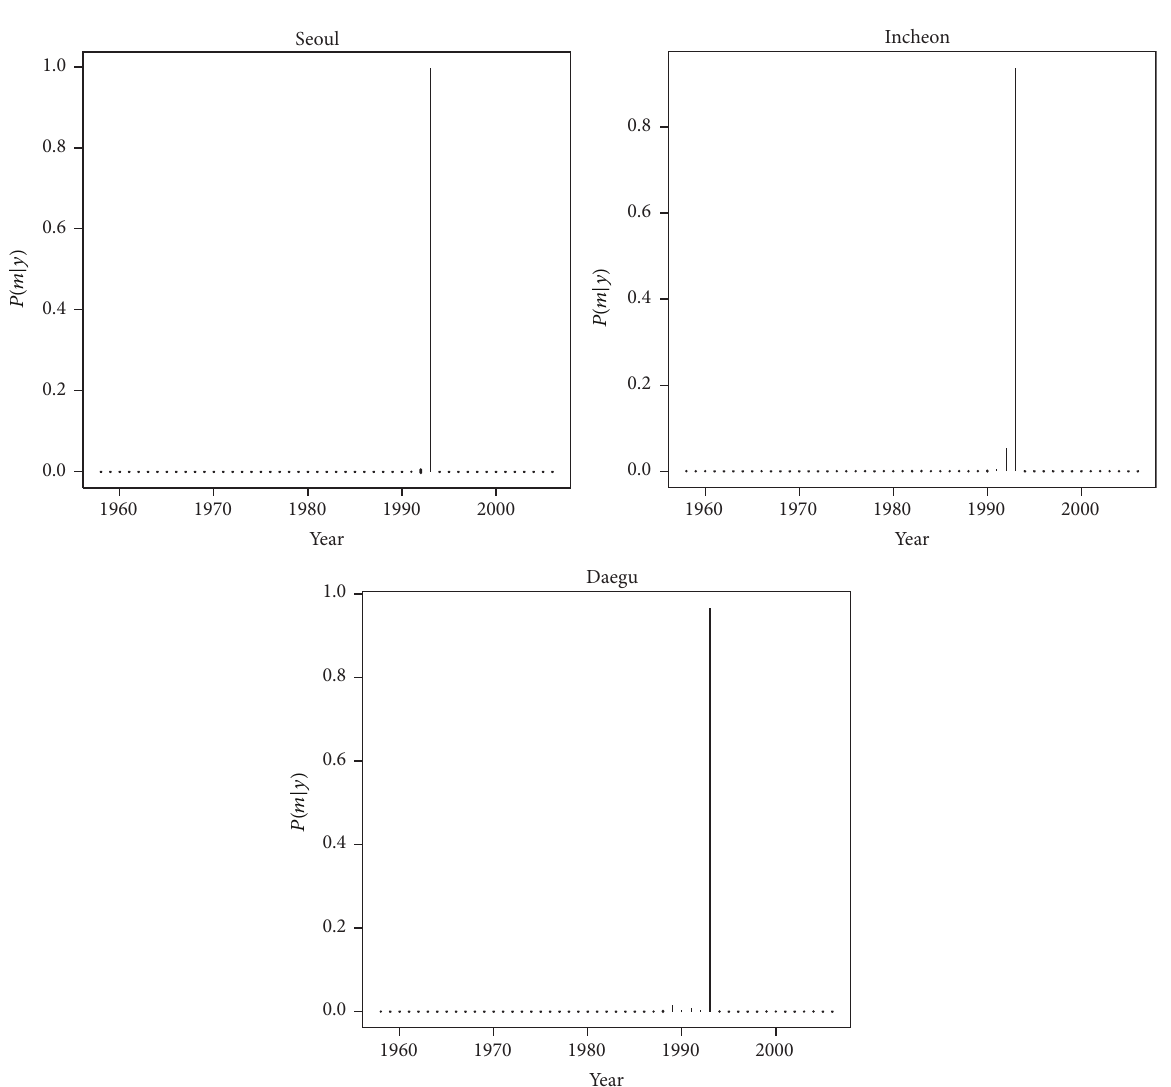
Figure 4: Posterior probability for the change-point, 𝑃(𝑚 | 𝑦) .